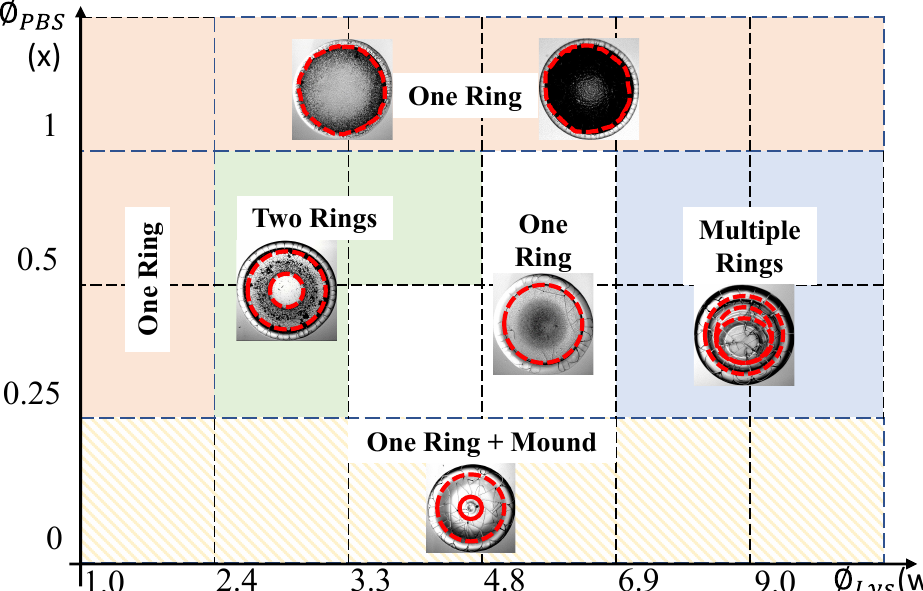
Figure 11. A phase diagram is established for the drying-mediated patterns observed in Figure 3. Different phases, indicated by distinct color shades—for example, one, two, and multiple rings in the drops—are presented as a function of various initial concentrations of Lys ( φ Lys along the X -axis) and the phosphate buffer saline ( φ PBS along the Y -axis). The hatched lines for φ Lys = 0 × indicate that the drops without adding any external salts are different from the drops with PBS by the presence of the mound-like structure in the central region. The representative image in each phase is provided where the dashed red-colored lines mark the rings, and the solid line depicts the mound-like